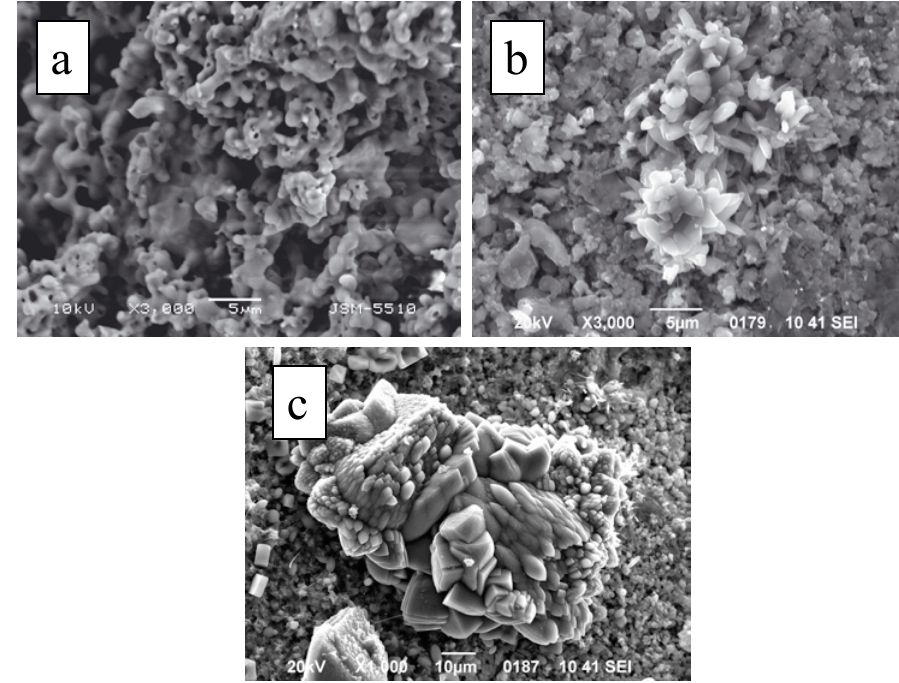
Figure 4. SEM of the CPS-2 surface before (a) and after 1 (b) and 3 days (c) immersion in 1.5 SBF